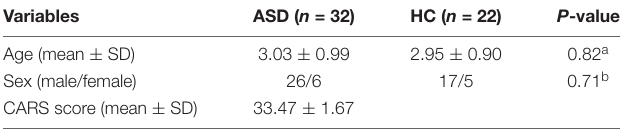
TABLE 1 | Demographic characteristics of the